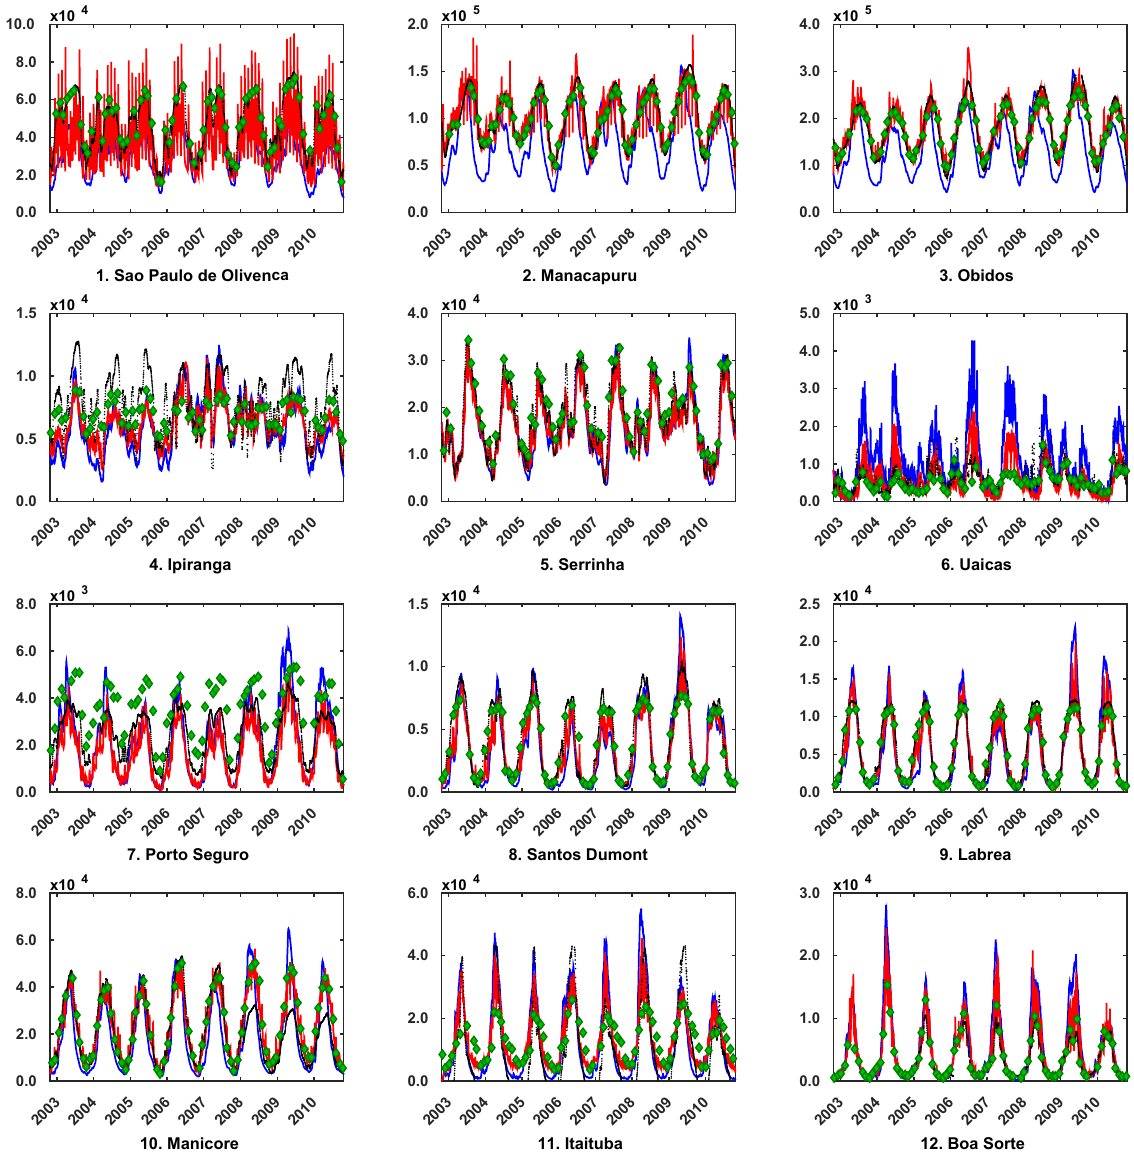
Figure 14. SE3-local ensemble mean analysis discharge (red line) compared to the free run discharge (blue line), the ENVISAT observed discharges (green markers) and the measured gauge discharges (black dots) from 25 September 2002 and for 8 years. In each panel, the x -axis represents time (in days) and the y -axis represents discharge (in m 3 s − 1